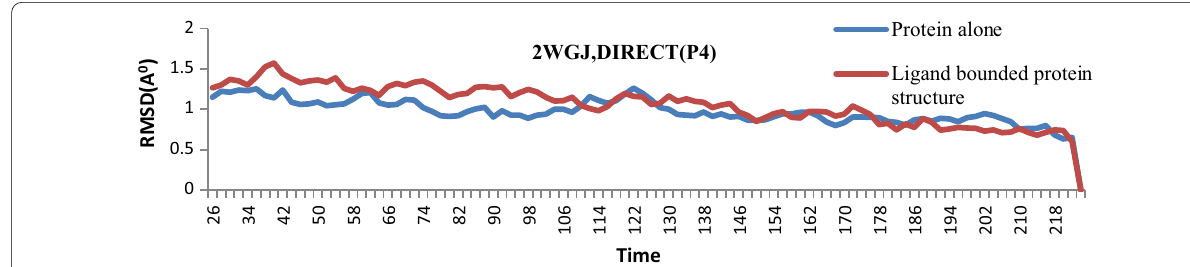
Fig. 3 RMSD graph of ligand-free protein and ligand bounded protein complex of C-MET protein